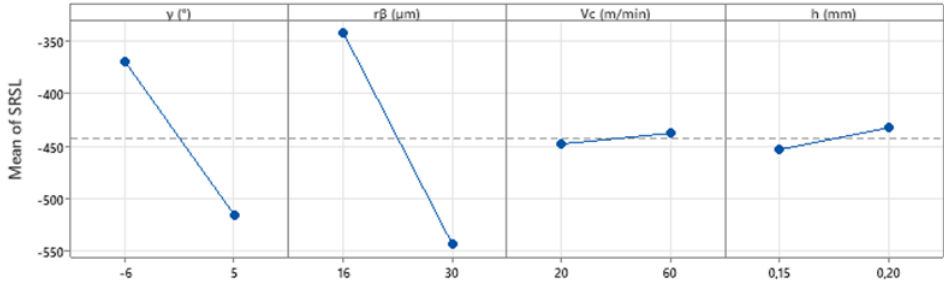
Figure 15. Influence of the cutting parameters on the SRSL based on all cutting conditions.